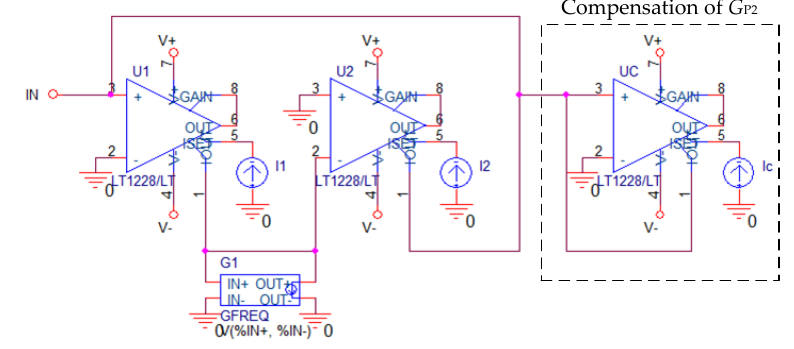
Figure 9. OrCAD Capture schematic of the simulated gyrator.